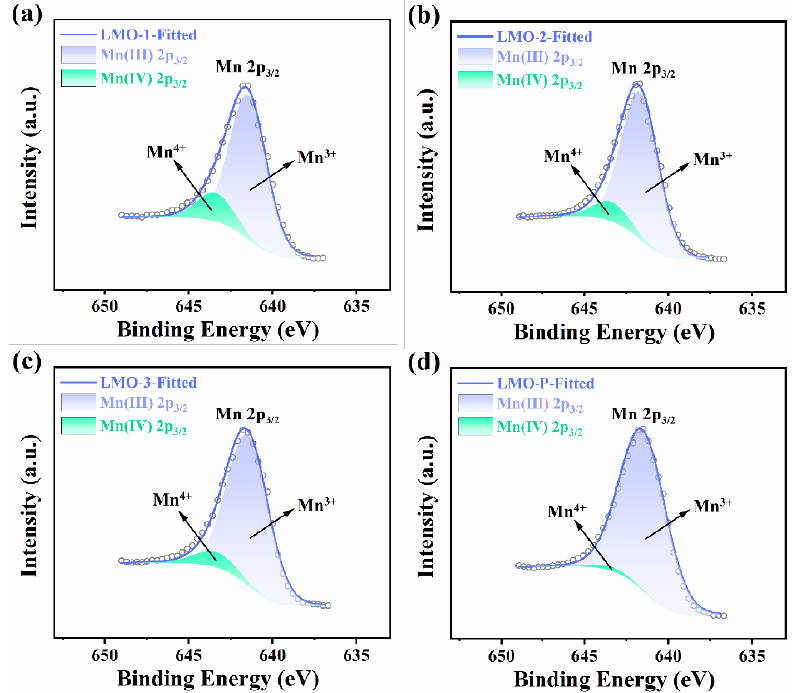
Figure 2. The XPS spectra of the various samples ( a – d ).